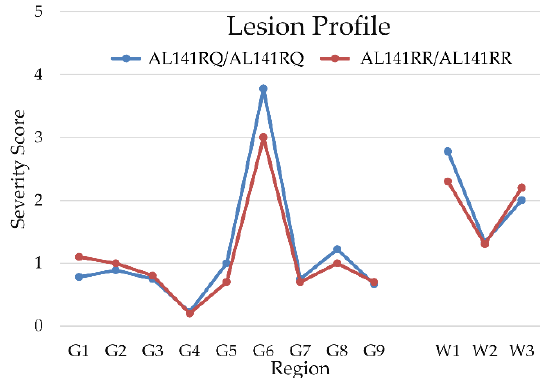
Figure 1. Mean vacuolation severity scores of lesion profiles of transgenic TgshpXI mice inoculated with Portuguese atypical scrapie of nine grey matter (G) and three white matter (W) regions, showing peaks at hippocampus, cerebellar white matter and peduncles. The blue and red lines describe the mean severity score of vacuolation produced by transmission of cases from AL 141 RQ/AF 141 RQ and AL 141 RR/AL 141 RR genotypes, respectively. Abbreviations: G1, dorsal medulla; G2, cerebellar cortex; G3, superior colliculus; G4, hypothalamus; G5, thalamus; G6, hippocampus; G7, septum; G8, medial area of the cerebral cortex at the level of the thalamus; G9, medial area of the cerebral cortex at the level of the septum; W1, cerebellar white matter; W2, decussation; W3, cerebral peduncles.